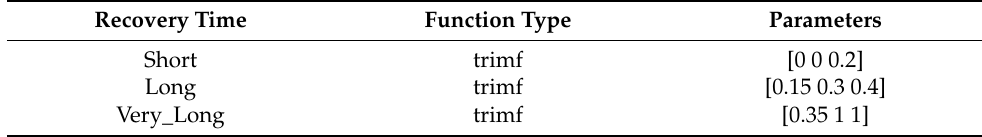
Table 3. Recovery time membership functions with three terms.